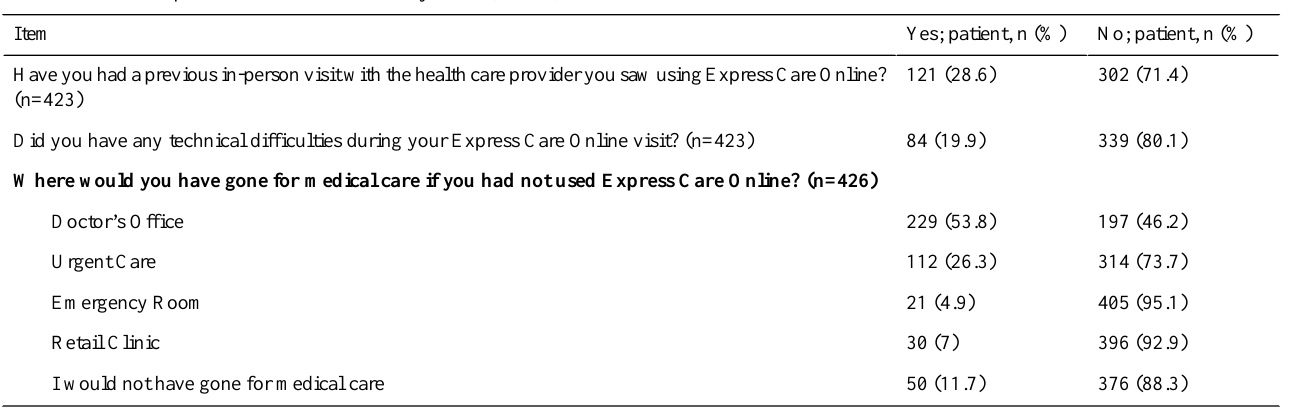
Table 5. Patient responses to dichotomous survey items